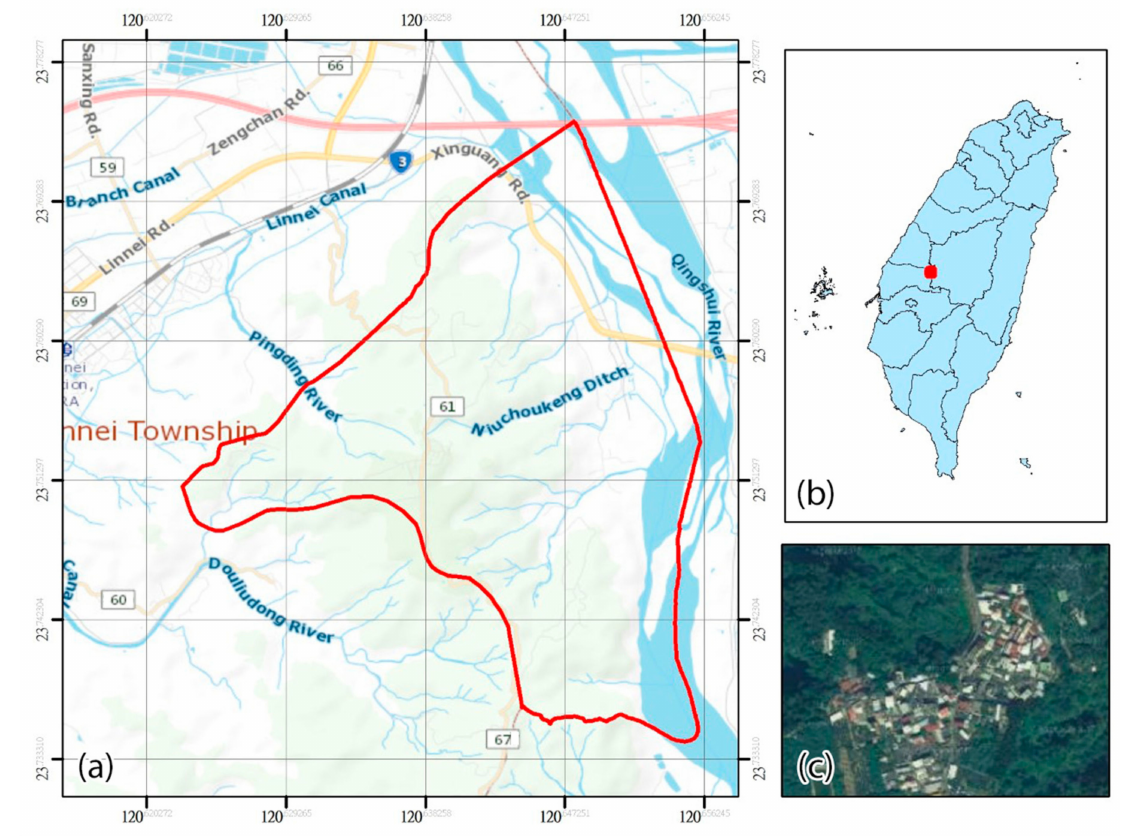
Figure 2. Pingding in Taiwan: ( a ) Pingding in the township of Linnei; ( b ) Pingding in Taiwan; ( c ) satellite image of